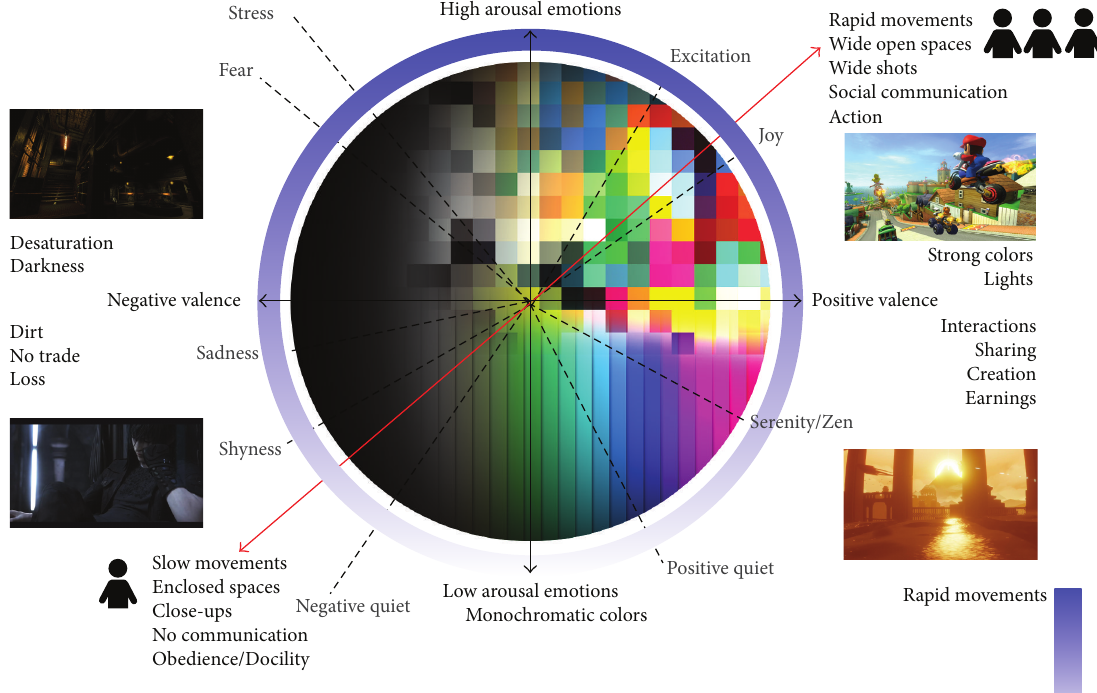
Figure 6: A tentative circumplex model for color scripting in video